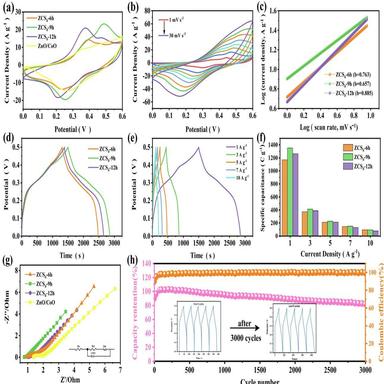
(a) CV curves of ZnO/CoO, ZCSd-6h, ZCSd-9h and ZCSd-12h (5 mV s1 ); (b) CV curves of ZCSd-9h electrode; (c) The linear fitted plots of log ip vs. log t of ZCSd-6h, ZCSd-9h and ZCSd-12h; (d) GCD curves of ZCSd-6h, ZCSd-9h and ZCSd-12h (1 A g1 ); (e) GCD curves of ZCSd-9h; (f) Specific capacity of ZCSd-6h, ZCSd-9h and ZCSd-12h; (g) EIS plots of ZnO/CoO, ZCSd-6h, ZCSd-9h and the ZCSd-12h; (h) Cycling stability of ZCSd-9h over 3000 cycles at 8 A g1 .